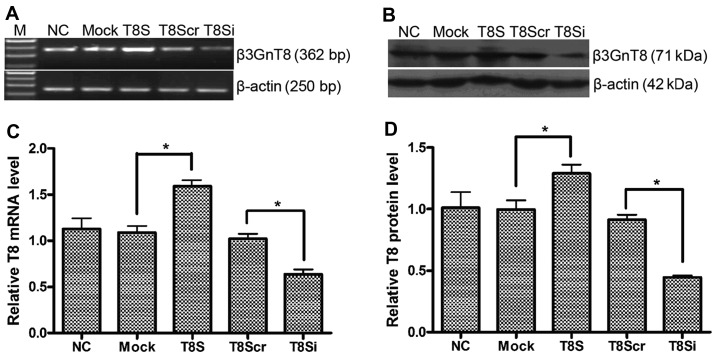
Expression of β1,3-N-acetylglucosaminyltransferase-8 (β3GnT8) mRNA and protein in different groups. (A) Reverse transcription-polymerase chain reaction (RT-PCR) results of β3GnT8 mRNA. (B) Western blot results of β3GnT8 protein. (C) Analysis of β3GnT8 relative mRNA level. (D) Analysis of β3GnT8 relative protein level. Data were obtained from triplicate experiments and are indicated as means ± standard deviation (SD). *P<0.05.